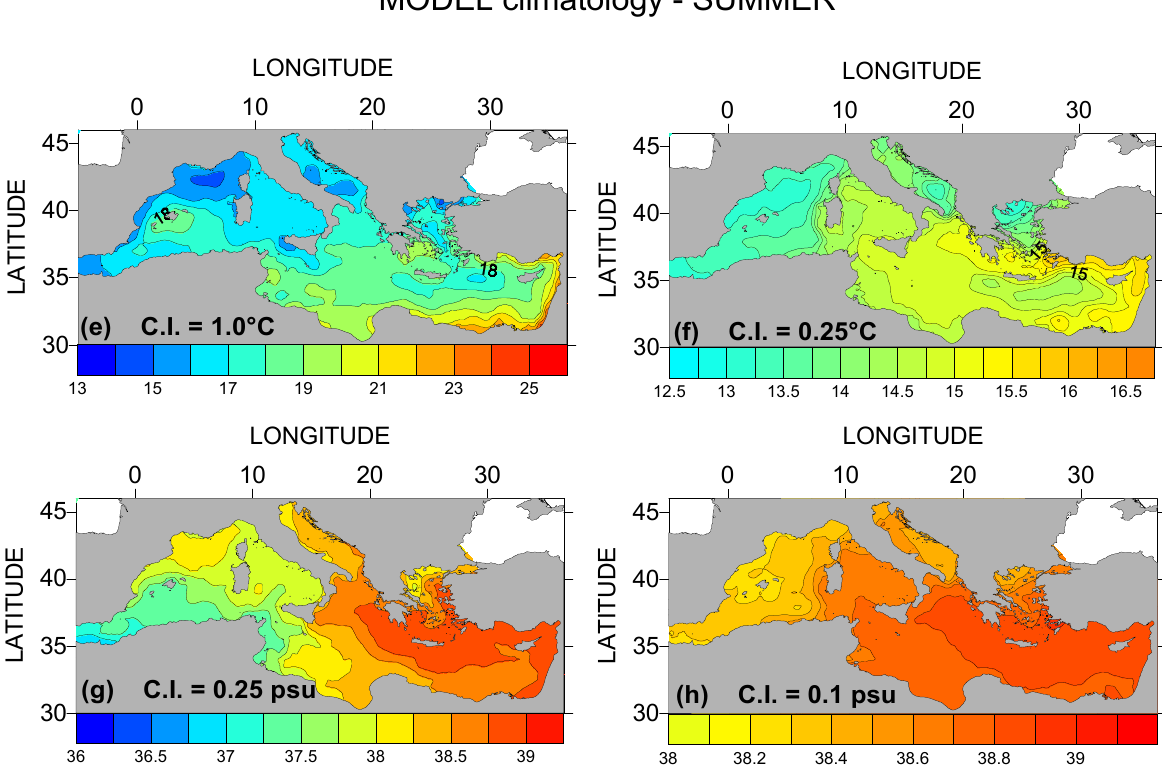
Fig. 3. Summer MED6 and model climatological fields at 50m and